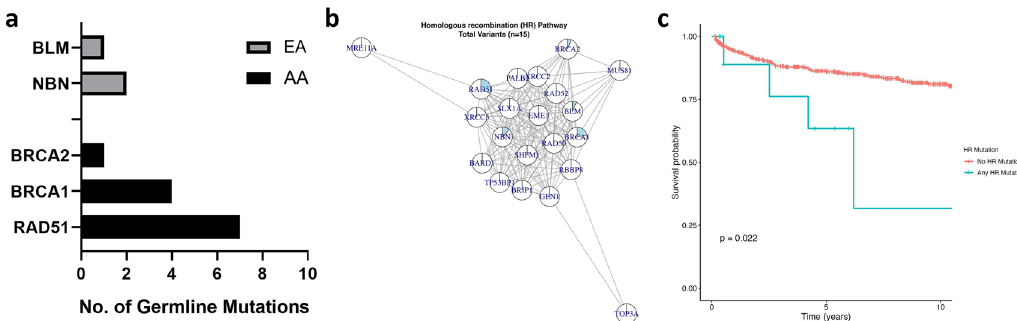
Fig. 4 HR DDRG Pathway based Germline Mutations Pro fi ling in AA and European Ancestry Men. a Frequency of germline mutations in HR pathway in AA and EA men ( b ) The pie chart indicates the genes ( RAD51, BRCA1, BRCA2, BLM, NBN ) harboring 15 HR pathway mutations ( c ) Patients with variants in HR pathway had developed BCR faster than the patients without HR mutations, when longitudinally followed up after RP ( P = 0.022, HR 3.34). The Kaplan – Meier curves were plotted, and log-rank tests were used to assess statistically signi fi cant differences between the two curves. Two-sided test was performed to assess the p value. Source data are provided as a Source Data fi